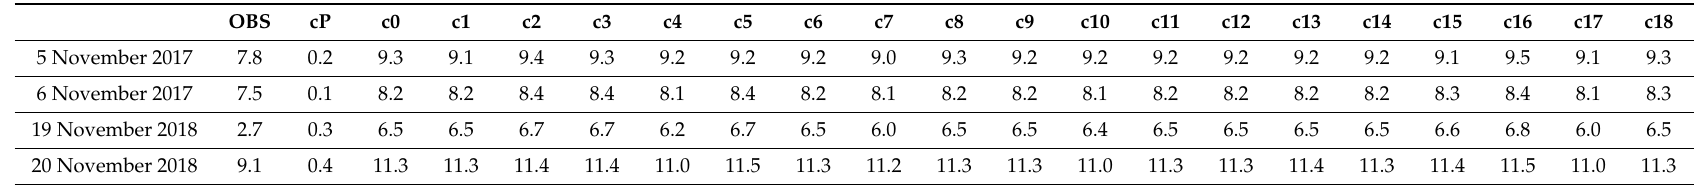
Table 7. Daily minimum T2m values ( ◦ C) averaged over the SCIA stations for two days, for observational and model data (all configurations). Maximum deviation (cP) from the reference simulation with the initial condition